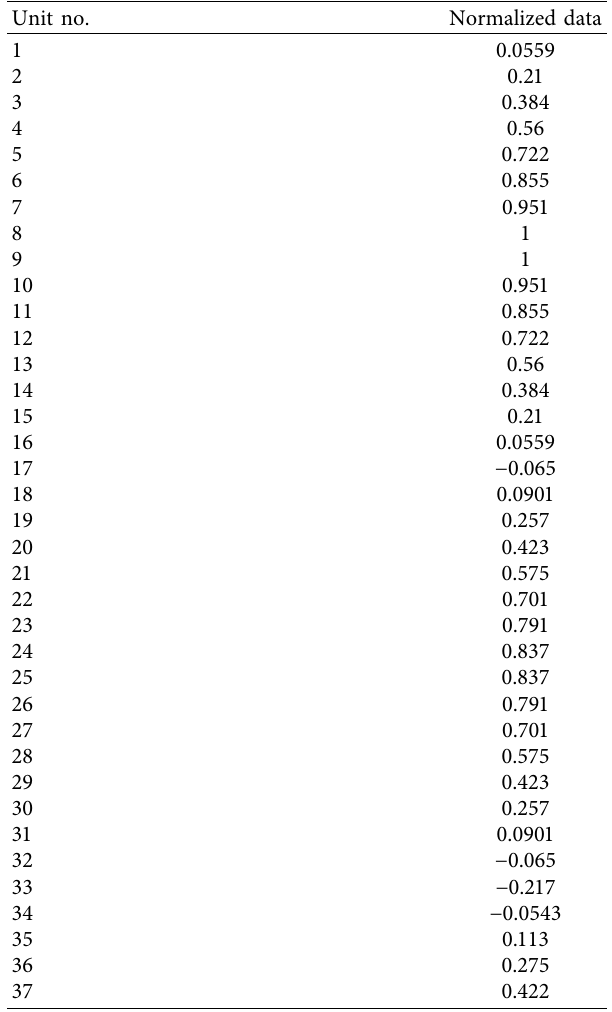
Table 4: Normalized deformation data at the center of the antenna element.